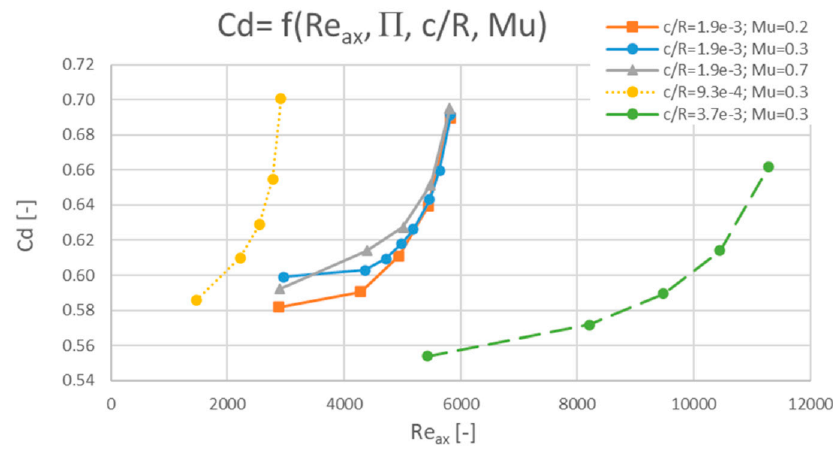
Figure 4. Discharge coefficient for the researched OAS for different e ax , Π , c / R , and M u